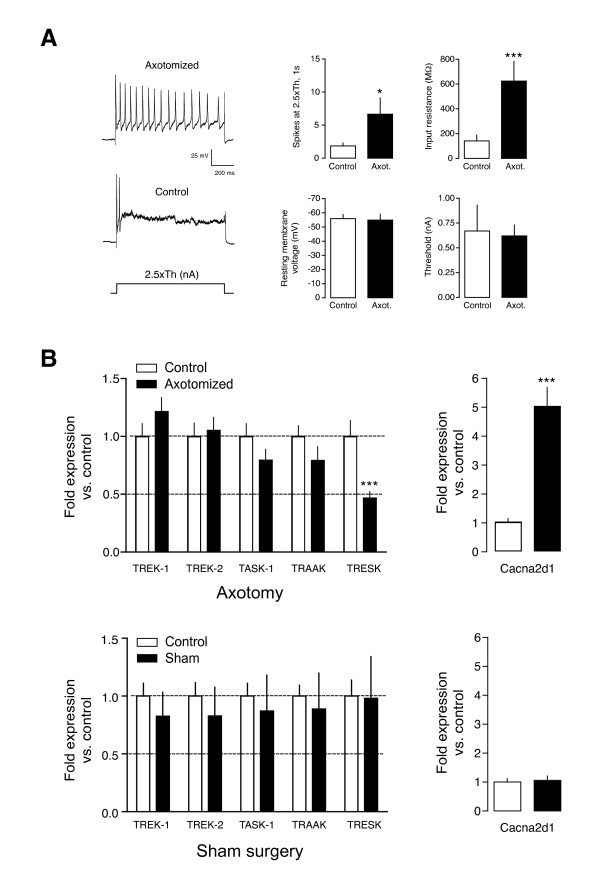
Axotomy effects on background K+ channels. A. Sciatic nerve axotomy induces hyperexcitability of DRG sensory neurons recorded in the acutely dissected ganglion. Excitability was measured as the number of spikes fired by a 1s pulse 2.5× action potential threshold. Left. Examples of an axotomized and a contralateral uninjured control neuron. Right: Quantification of number of spikes fired, input resistance, resting membrane potential and action potential threshold. *p < 0.05; ***p < 0.001 t-test axotomized vs. control (n = 8 for each group). B. Effect of axotomy (top) and sham surgery (bottom) on K2P channels mRNA. Expression changes were normalized with the contralateral uninjured side for each independent animal (n = 4) and expressed as mean ± SEM. A significant decrease in expression was found for TRESK (***p < 0.001). As a positive control, expression of the calcium subunit Cacna2d1 was detected and found upregulated after axotomy (p < 0.001), as previously described, but not after sham surgery.